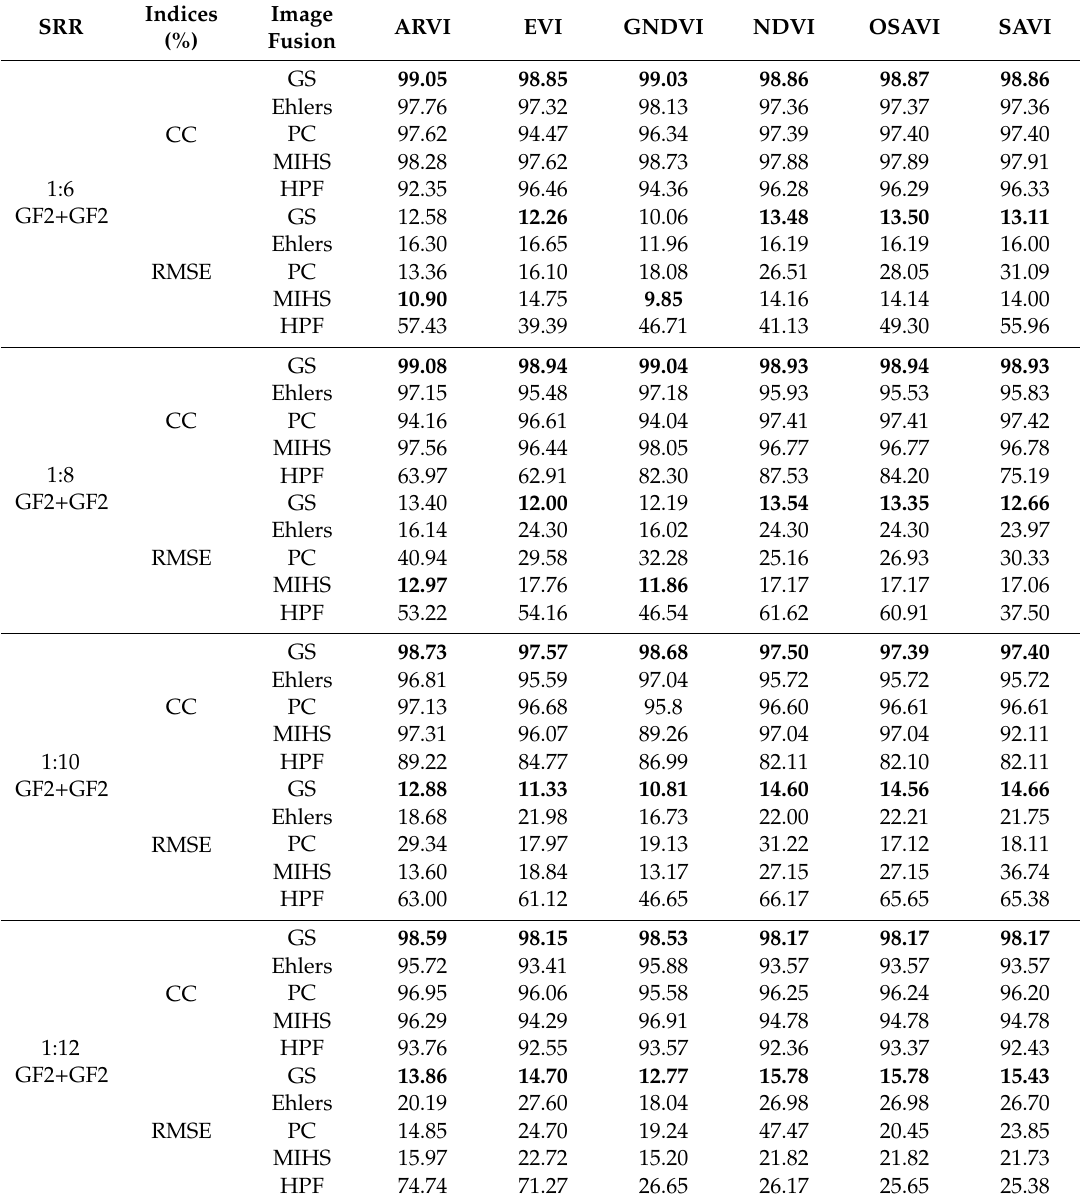
Table 5. Quality of FVI result in single-sensor fusion (values in bold font indicate good quality).